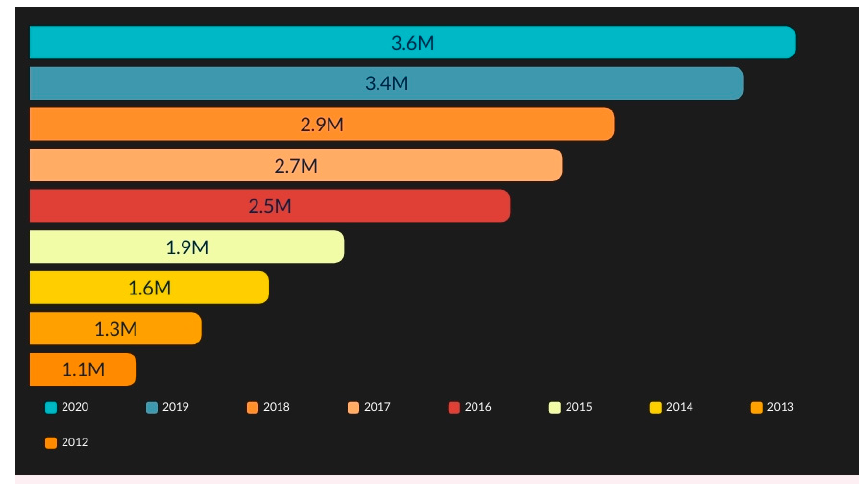
Figure 1. Number of smartphone users worldwide [3].